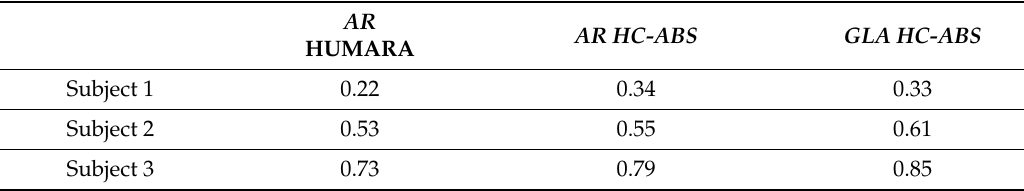
Figure 2. Comparison between Human Androgen Receptor methylation analysis (HUMARA) and ultra-deep methylation sequencing. (A) HUMARA strategy to verify skewness on AR locus. On the left, an example of AR locus with no skewness. On the right, an example of the AR locus with skewness. (1) AR locus with two sites for HpaII restriction enzyme located upstream of the CAG repeats region. The two X alleles are indicated as Xm and Xp. (2) HpaII enzyme cuts CCGG nucleotides only when the dimer CG is not methylated. On the left, the enzyme HpaII can cut on 50% of molecules, both on Xp and on Xm. On the right, the cutting capacity of the enzyme is on 70% of alleles belonging to Xm and on 30% of the alleles belonging to Xp. (3) Agarose gel after PCR of the two putative samples. Undigested and digested samples are shown. Thanks to the di ff erences in CAG repeats on the two alleles, it is possible to distinguish on the agarose gel the Xm and Xp. On the left, where there is no skewness, the two bands show the same intensity, since the cut occurs on the same percentage of molecules both in Xp and in Xm. On the right, the shorter allele shows a lower intensity than the longer one, since the cut occurs on 30% of Xp and on 70% of Xm. ( B ) Ultra-deep methylation strategy on the AR locus. (1) The AR amplicon is analyzed by HC-ABS . All the analyzed CpG sites are shown as black circles. Di ff erent CAG repeats are indicated for Xm and Xp. (2) Amplicon library is prepared and sequenced by Next Generation Sequencing (NGS). The number of repeated CAGs are indicated in red. CpG dimers are indicated in bold. After sequencing, the two alleles are sorted according to the di ff erent number of repeated CAGs. (3) Separated alleles are analyzed with the AmpliMethProfiler Tool [18]. After bioinformatic analysis, the methylation average at each CpG, methylation matrix, epiallele count and alpha and beta diversity are obtained for each separated allele. Table 1. Quantification of the skewed X-inactivation at the AR and GLA target regions. Quantifications of the skewness at the AR locus calculated using the HUMARA and the HC-ABS methods are reported in the first column and in the second column, respectively. Quantification of the skewness at the GLA locus calculated with the HC-ABS method is reported in the third